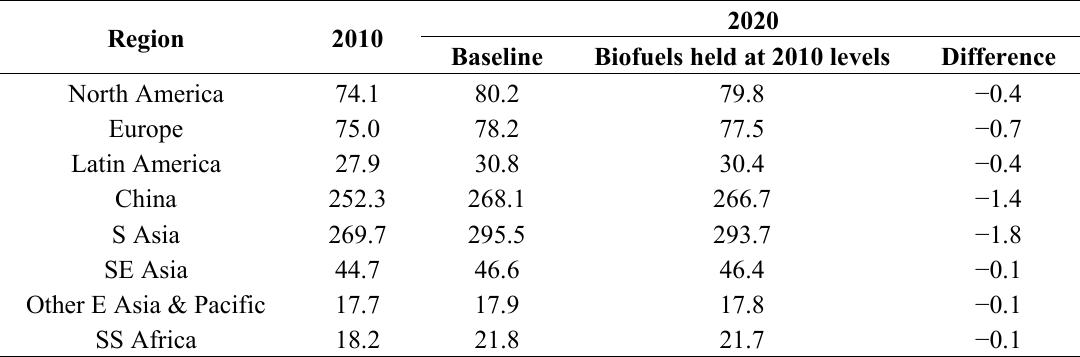
Table 3. Total crop area under baseline and scenario (millions of